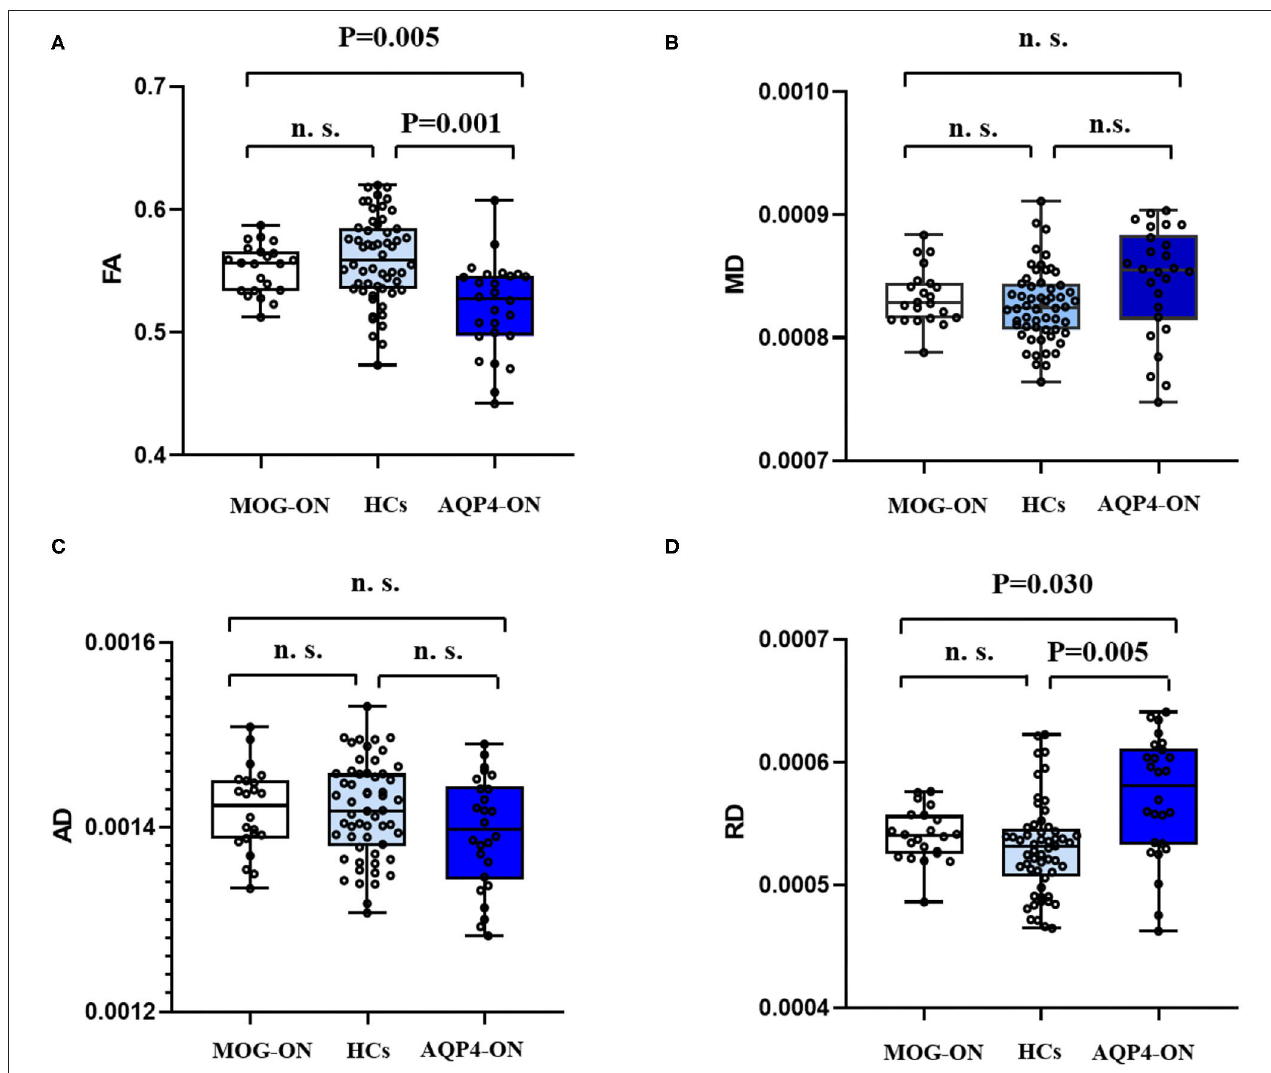
FIGURE 2 | DTI results. Boxplot of mean FA values (A) , MD values (B) , AD values (C) , and RD values (D) for posterior thalamic radiation (include OR) in MOG-ON (left, white), HCs (middle, light blue), and AQP4-ON (right, dark blue). FA, fractional anisotropy; MD, mean diffusivity; AD, axial diffusivity; RD, radial diffusivity; HC, healthy control; MOG-ON, optic neuritis patients with MOG antibody; AQP4-ON, NMOSD patients with AQP4 antibody positive and a history of ON; OR, optic